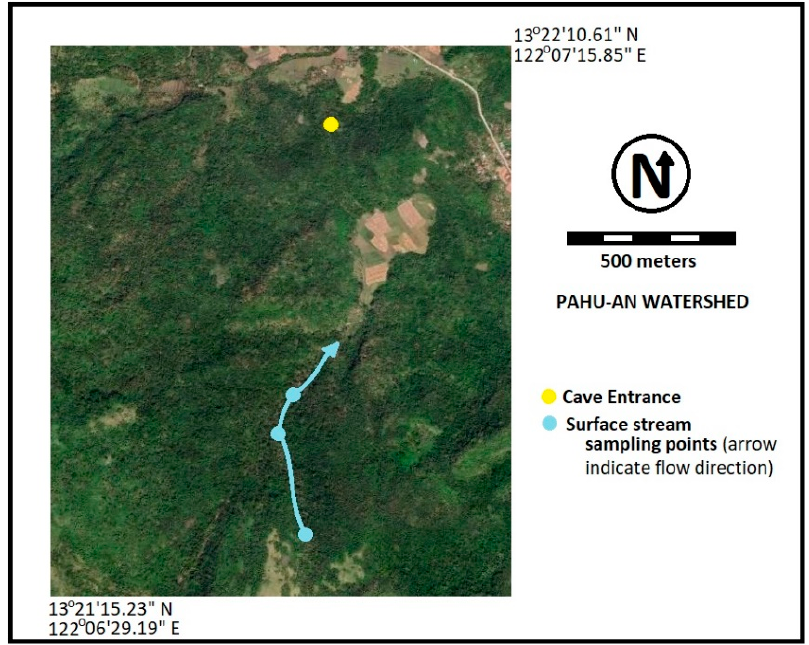
Figure 1. Sampling site in Pahu-an Cave and vicinity showing the surface stream and the remaining forest cover in the area (modified from Google Earth [2018] and Mines and Geoscience Bureau Geological Database Information System generated maps [http://gdis.mgb.gov.ph/mgbpublic]).